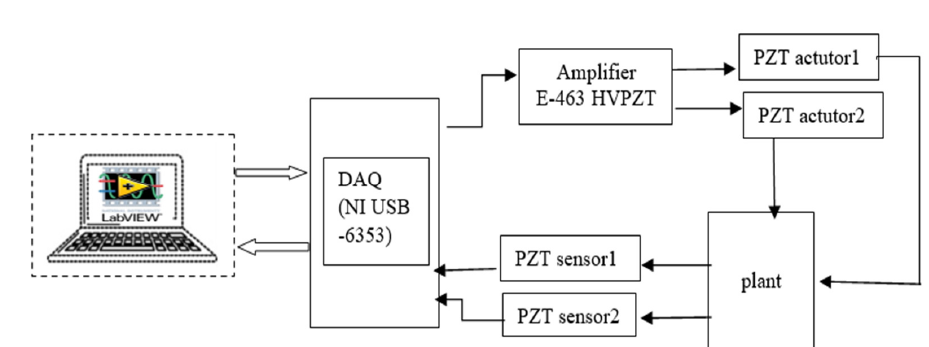
Fig. 5. The schematic diagram steps of experimental work.